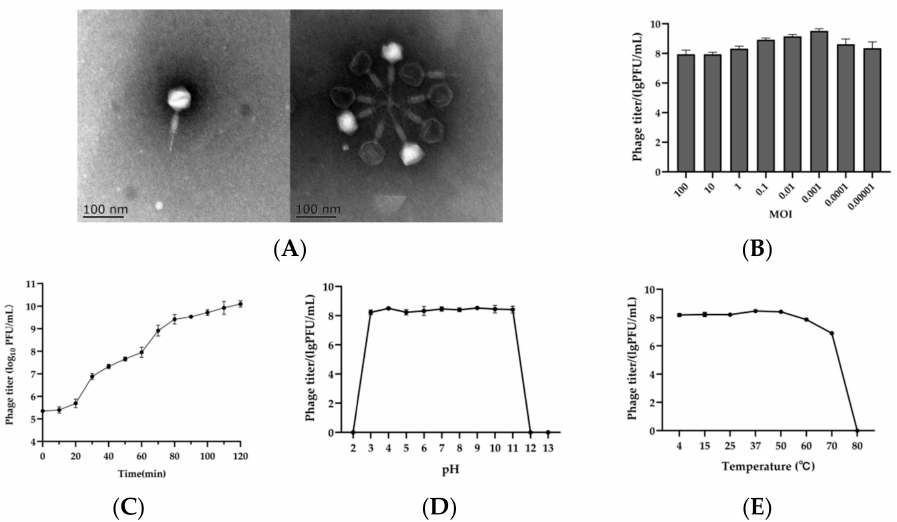
Figure 1. Biological characteristics of phage SPJ41. ( A ) Transmission electron micrographs of SPJ41. ( B , C ) Optimal MOI and replication curve of phage SPJ41. ( D , E ) Stability of SPJ41 at different pH values and